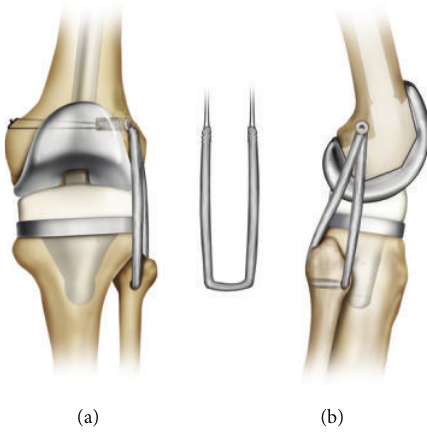
Figure 2: Representation of the fibular-based posterolateral corner reconstruction with tibialis anterior allograft and its relationship to the condylar femoral constrained